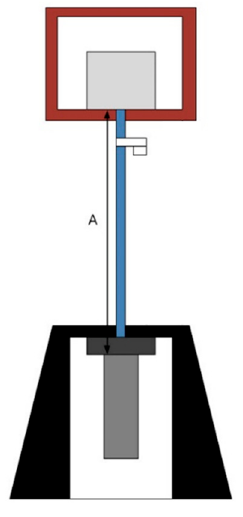
Figure 8. Test setup.